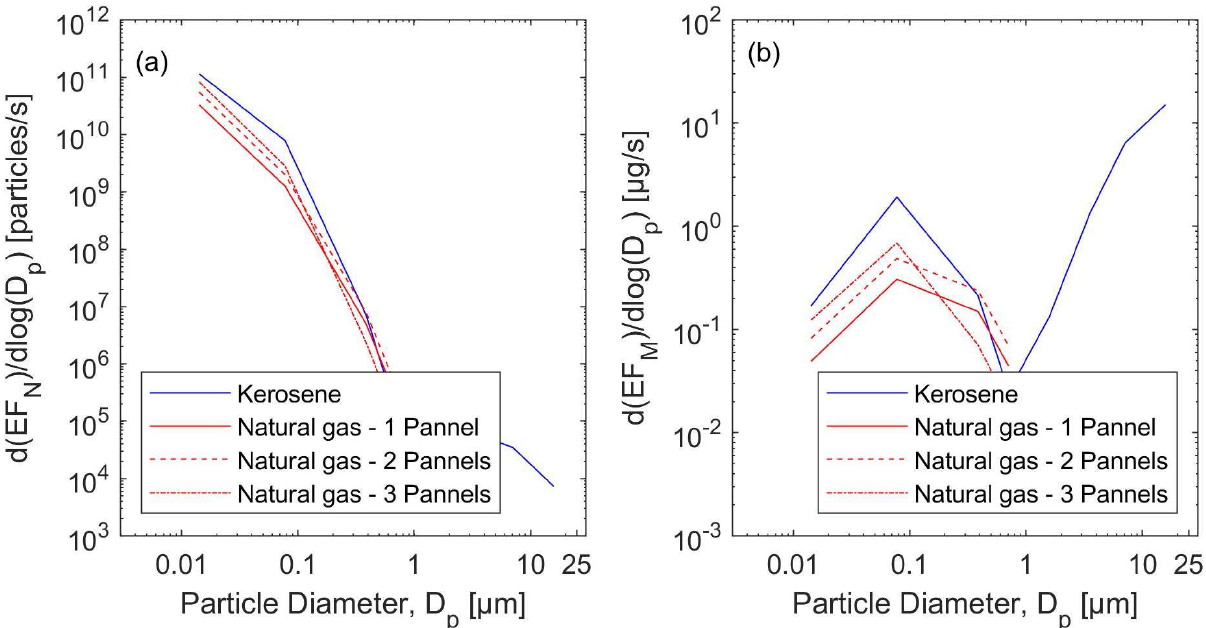
Figure 8. The overall emission rates during all scenarios of the heaters’ operation, presented in the form of ( a ) particle number size distributions and ( b ) particle mass size distributions.